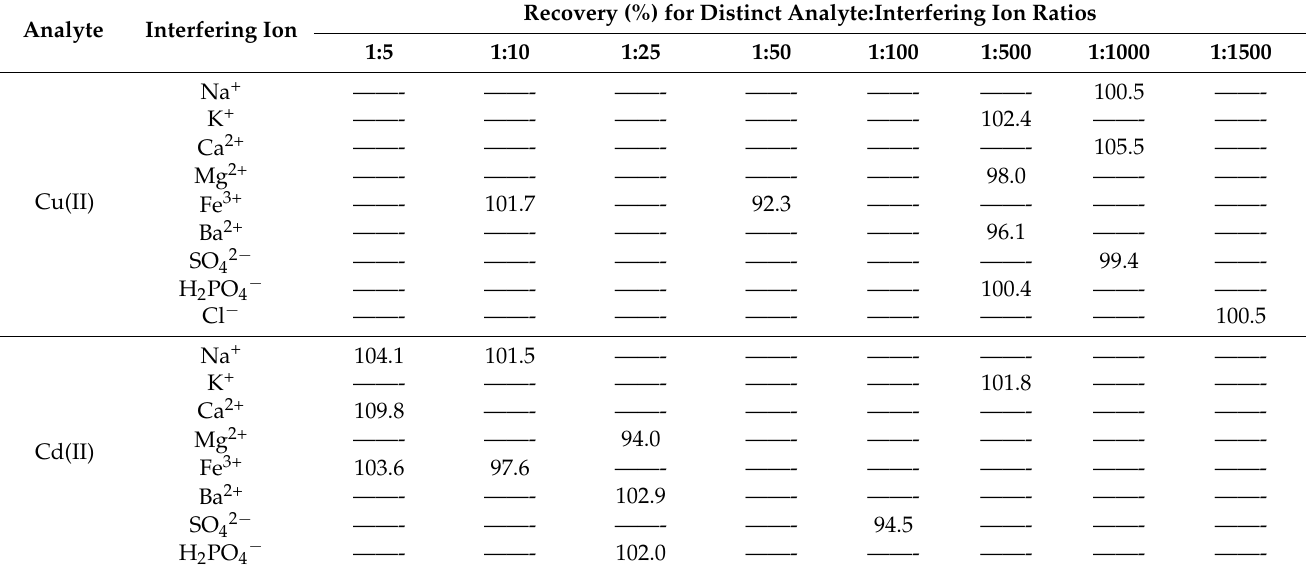
Table 7. Influence of coexisting ions in the preconcentration of Cu(II) and Cd(II).